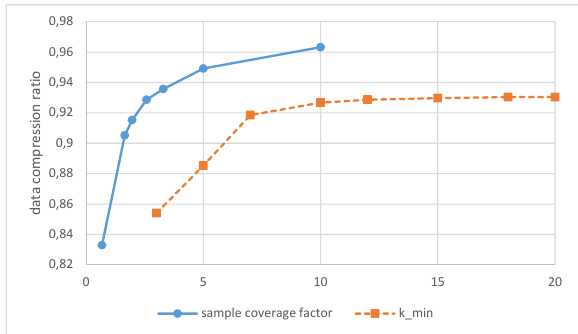
Figure 9. Resulting data compression ratio for different values of the sample coverage factor and k min .